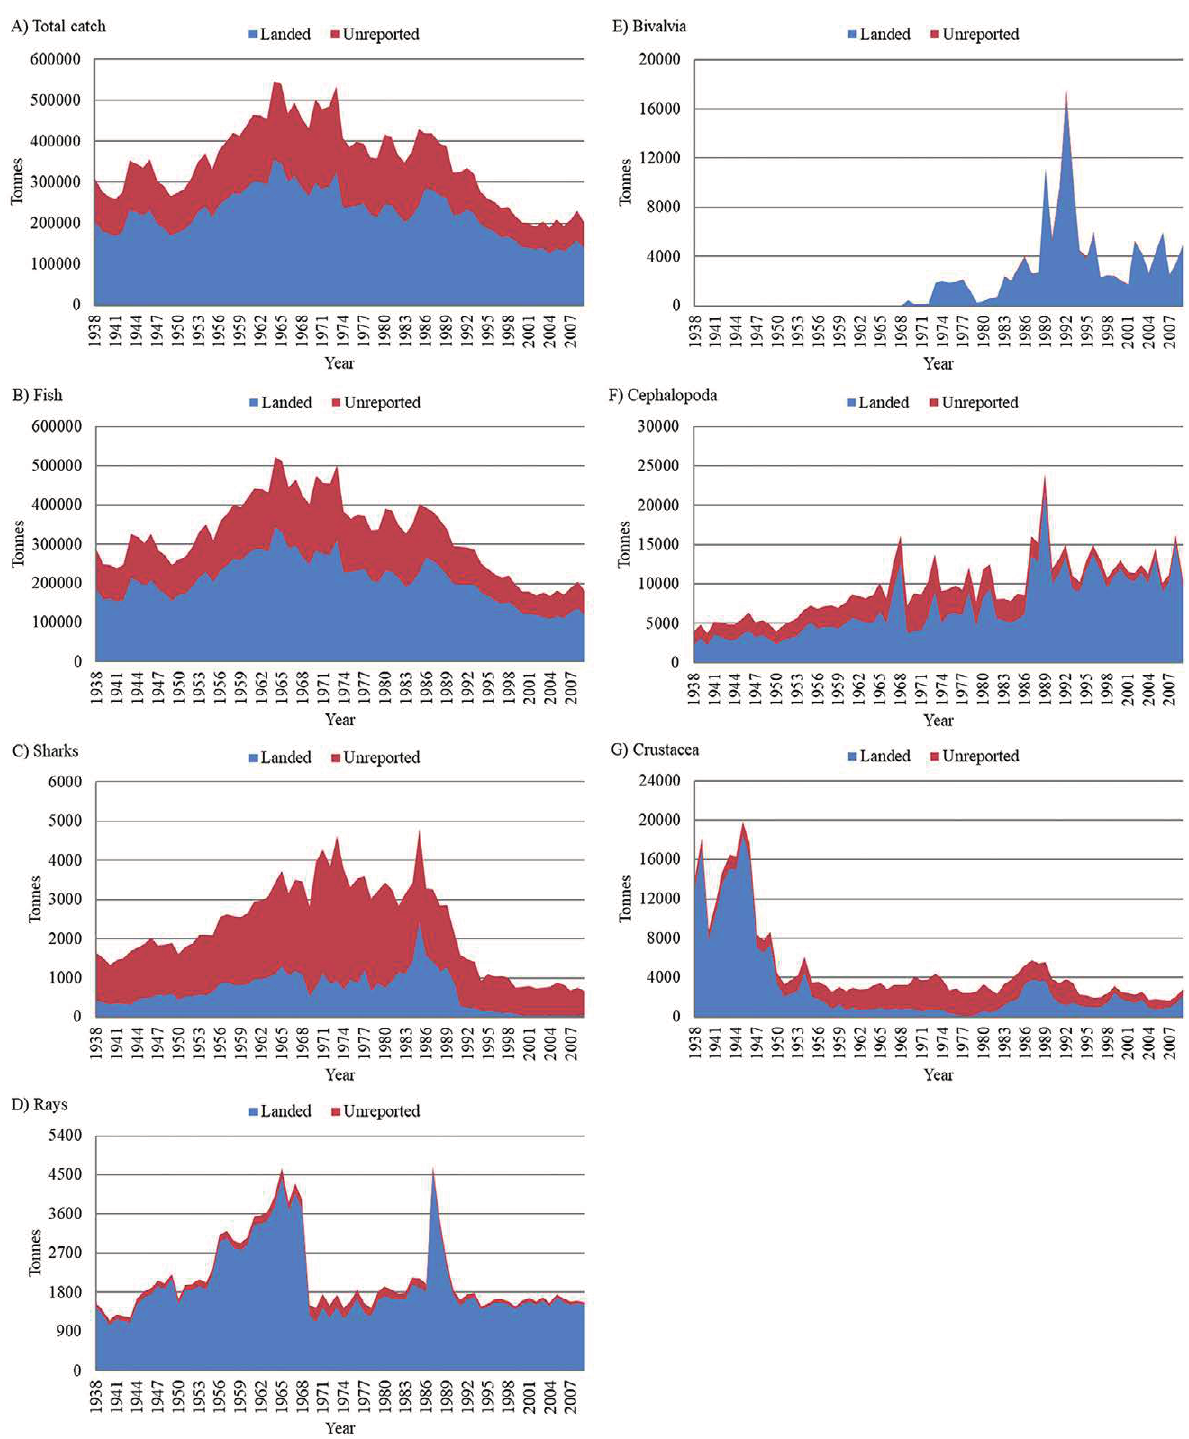
Fig. 1. – Total landed and unreported (discarded) catches for different commercial groups between 1938 and 2009. A, Total catches; B, fish; C, sharks; D, rays; E, Bivalvia; F, Cephalopoda; and G, Crustacea. Source: Portuguese National Statistical Office – ble 2). Fish accounted for 93.5% of the total unreported catches, with an average of 115493 t/y. The contribu- tions of cephalopods and crustaceans to the unreported catches are minor compared with those of fish: 1.9% and 1.4% of total unreported catches, with averages of 2345 and 1754 t/y, respectively (Fig. 1, Table 2). The shark